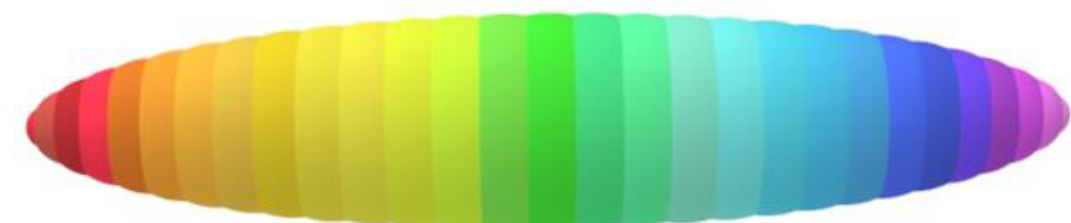
* 21 M  spheres. Figure 9. The optimized cover of the spheroid E by M ∗ = 21